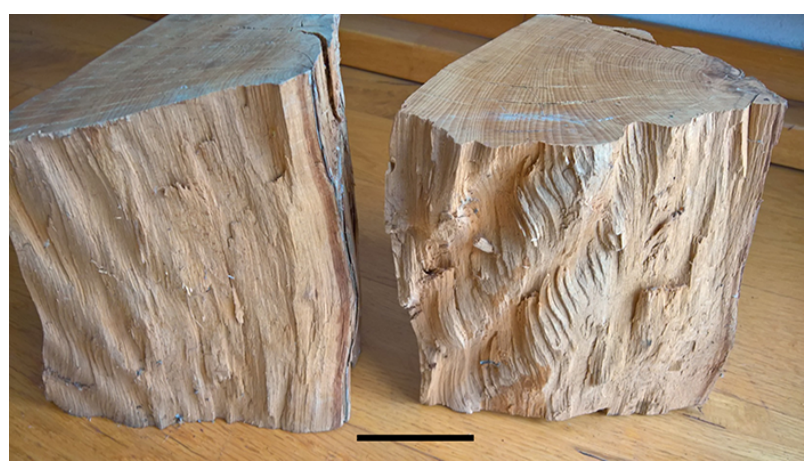
Figure 6 Radial split faces of two beech wood samples with superimposed radial and tangential waviness; in the le sample both periodic patterns moved upward, while, in the right one – in the opposite direction; especially in the right sample superposition of T-wave and R-wave is very clear because of their amplitude – wood grain considered in 3D is inclined not only away and towards the viewer but also away and towards the pith, which in both samples is located on their right side; the apical–basal polarity of both samples is concordant, and their upper transverse surfaces are apical. Scale bar: 70